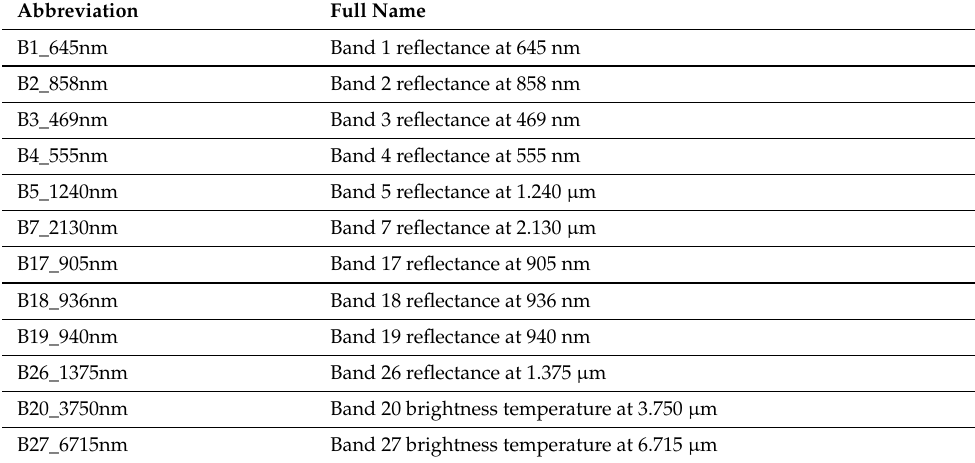
Table 3. Spectral and angular features used for cloud discrimination over water surfaces using MODIS